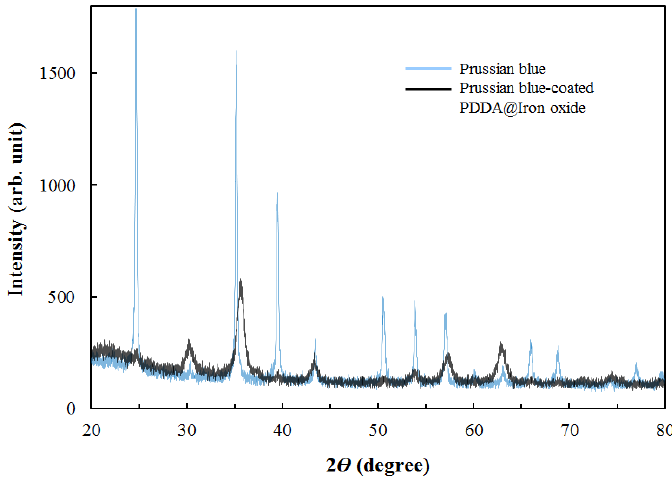
Figure 4. X-ray diffraction (XRD) peaks of Prussian blue and Prussian blue-coated PDDA@Iron oxide.